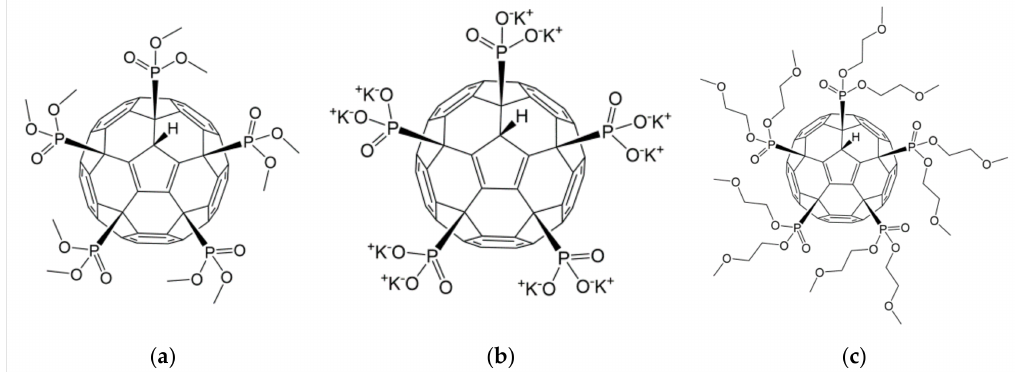
Figure 2. The molecular formula of the phosphonate derivatives of C 60 fullerene F1 ( a ), F2 ( b ), and F3 ( c ).